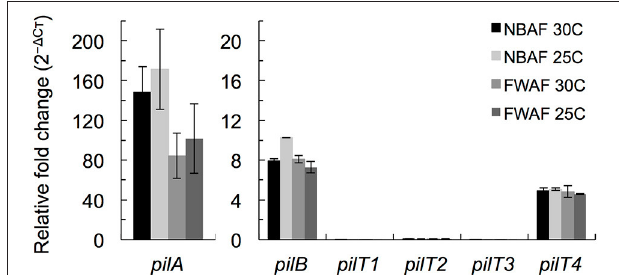
FIGURE 3 | Transcriptional expression analysis of pil genes in G. sulfurreducens by qRT-PCR. The expression levels of pilA, pilB, and the four pilT ( pilT1-4 ) genes of G. sulfurreducens were measured in duplicate samples in reference to recA controls in cultures grown in rich NBAF and mineral FWAF media incubated at pili-inducing (25 ◦ C) or non-inducing (30 ◦ C) temperatures. There were no statistically significant changes ( p < 0.01) in the relative expression of the target genes in reference to the pili-inducing conditions (FWAF 25C) in two-tailed pairwise comparisons using the t -test function of the Microsoft ® Excel ®